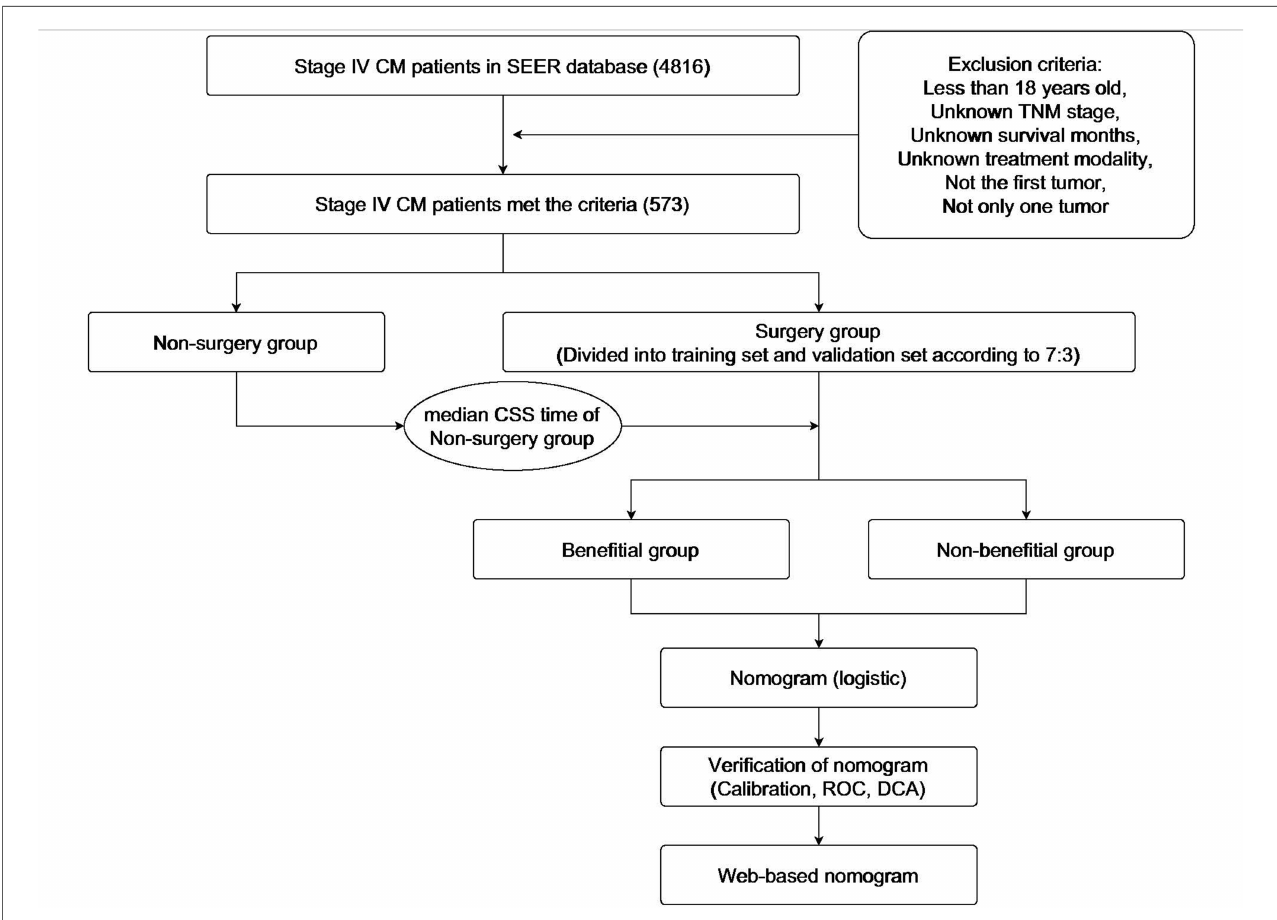
FIGURE 1 The design idea and work fl